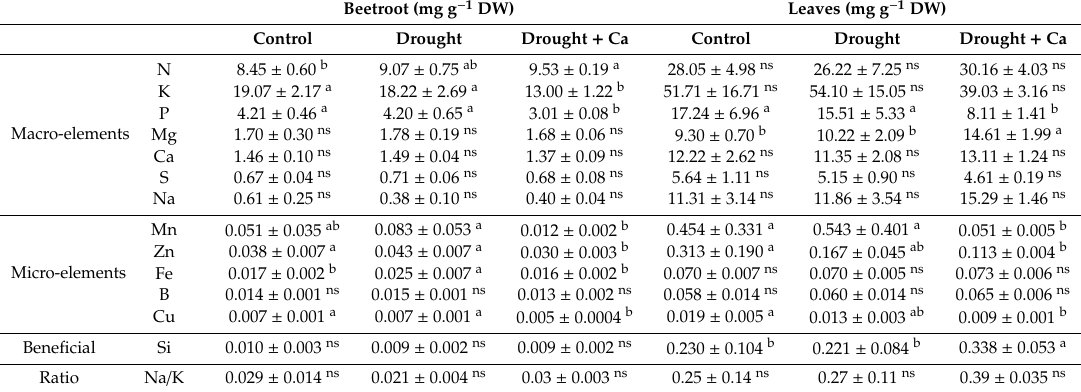
Table 1. Influence of foliar application of Ca 2 + on the beetroot and leaf elemental composition in sugar beet plants exposed to drought stress. Plants were grown in pots for a duration of 8 weeks. Five-week-old sugar beet plants were kept at 90% field capacity as control or exposed to drought stress (30% field capacity) for a duration of 3 weeks. Ca 2 + was applied at BBCH14 and BBCH18 in concentration of 5 L ha − 1 corresponding to 540 g Ca ha − 1 . Leaves and beetroot were harvested at 60 days after sowing for elemental analysis. Bars indicate means ± SEM. Di ff erent letters denote significant di ff erences according to ANOVA followed by SNK test ( p < 0.05; n = 6) and ns denotes non-significant di ff erences. Abbreviations are: N, nitrogen; K, potassium; P, phosphorus; Mg, magnesium; Ca, calcium; S, sulfur; Na, sodium; Mn, manganese; Zn, zinc; Fe, iron; B, boron; Cu, copper; and Si, silicon. Beetroot (mg g − 1 DW) Leaves (mg g − 1 DW) Control Drought Drought + Ca Control Drought Drought +